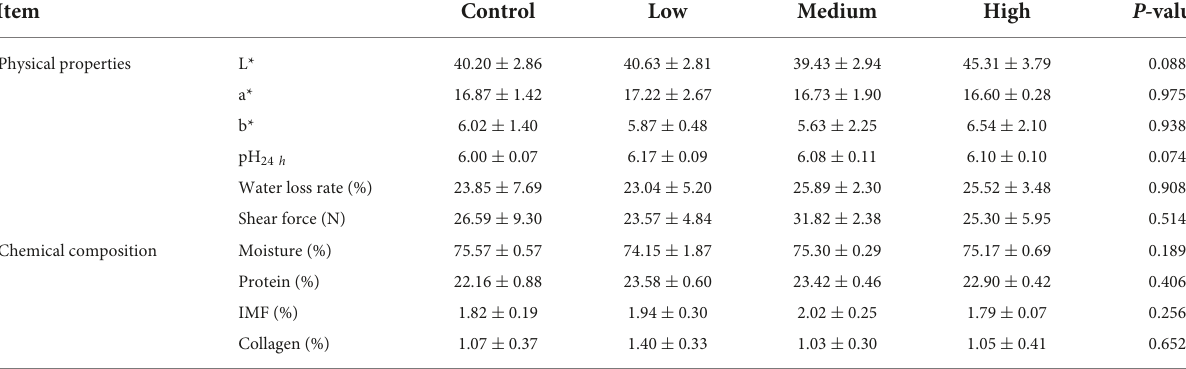
TABLE 4 Effects of different dietary linseed oil levels on breast muscle quality of 56 days ducks.